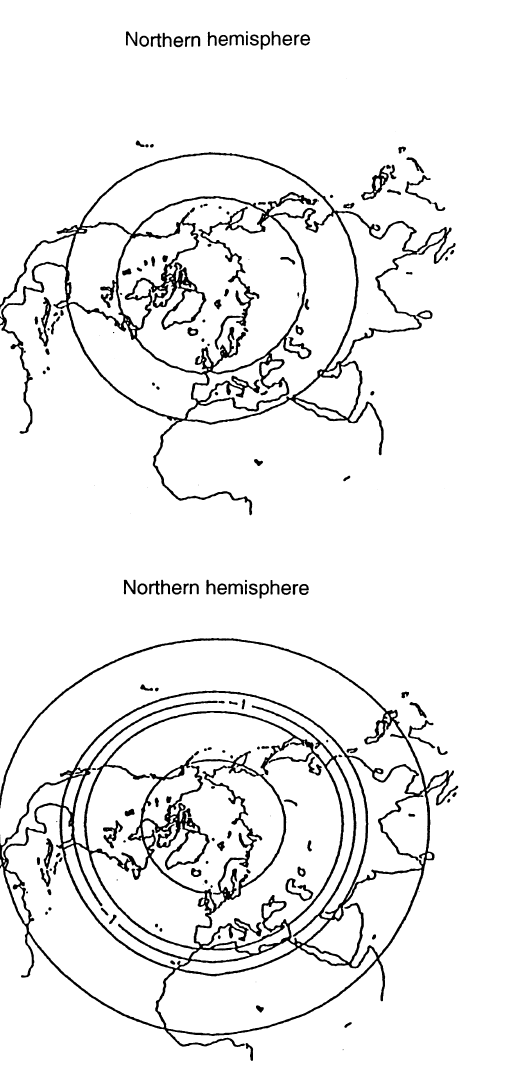
Fig. 6. As Fig. 5 but with no planetary wave forcing at the